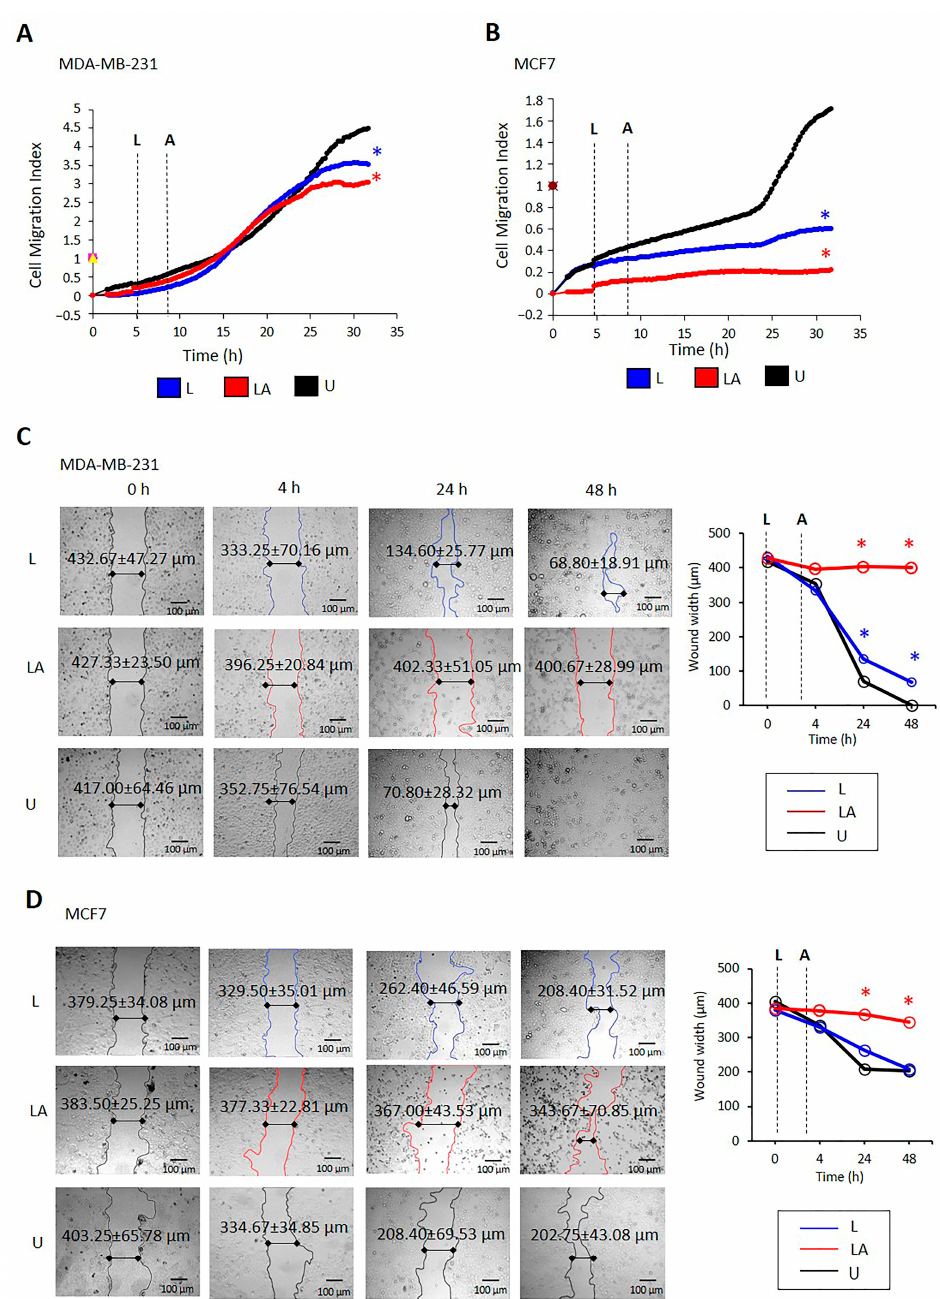
Figure 5. The effect of NLRP3 activation on the migration of MDA-MB-231 and MCF-7 cells. Cells were incubated with LPS (1 μ g/mL, 3 h) to activate NLRP3, followed by ATP treatment (5 mM ATP; 25 min) to form an inflammasome complex. Images were captured before LPS treatment (time 0), 30 min after ATP treatment (time 4), and 24–48 h after LPS/ATP treatment. The effect of LPS only and LPS/ATP on migration kinetics in MDA-MB-231 ( A ) and MCF-7 ( B ) cells. Light-colored cells are attached, whereas dark color cells are detached [36]. Data represent three technical repeats. p value was calculated at the 24th hour using the one-way ANOVA and Tukey test. The effect of LPS only and LPS/ATP on the wound area size in MDA-MB-231 ( C ) and MCF-7 ( D ) cells. Images were analyzed using Image J software. The p value was calculated using the one-way ANOVA and Tukey test. Data represent five technical repeats. * The mean difference is significant at 0.05 for all analyses (blue: LPS-only-treated cells, red: LPS/ATP-treated cells). U: untreated, L: LPS, LA: